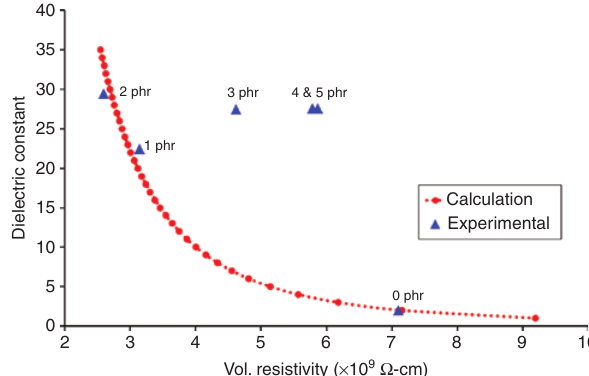
Figure 9: Numerical simulation of dielectric constant as a function of volume